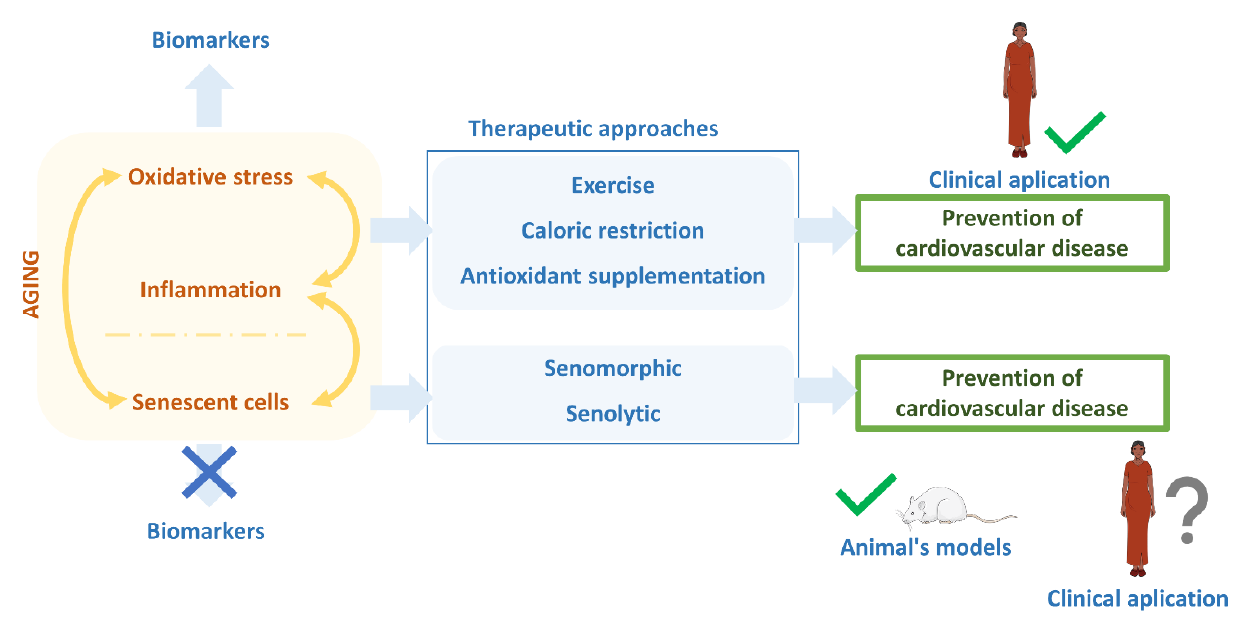
Figure 3. Estate of antiaging therapies. The aging process is characterized by increased oxidative stress, inflammation, and senescent cells, giving feedback to each other. Lowing oxidative stress and inflammation, which have biomarkers to know their state, are currently the best therapeutical op- tions for reducing the aging rate and preventing age-related diseases like cardiovascular disease. For that, exercise, caloric restriction, or antioxidant supplementation have been the ideal therapeutic